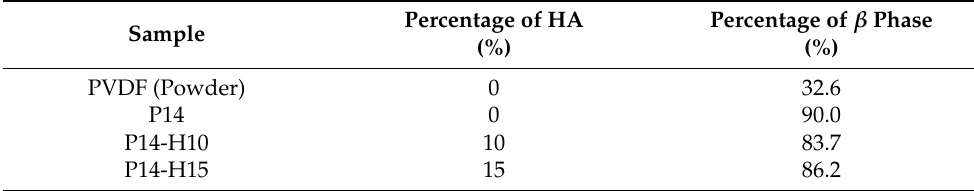
Table 1. β -phase amounts calculated for different PVDF-HA